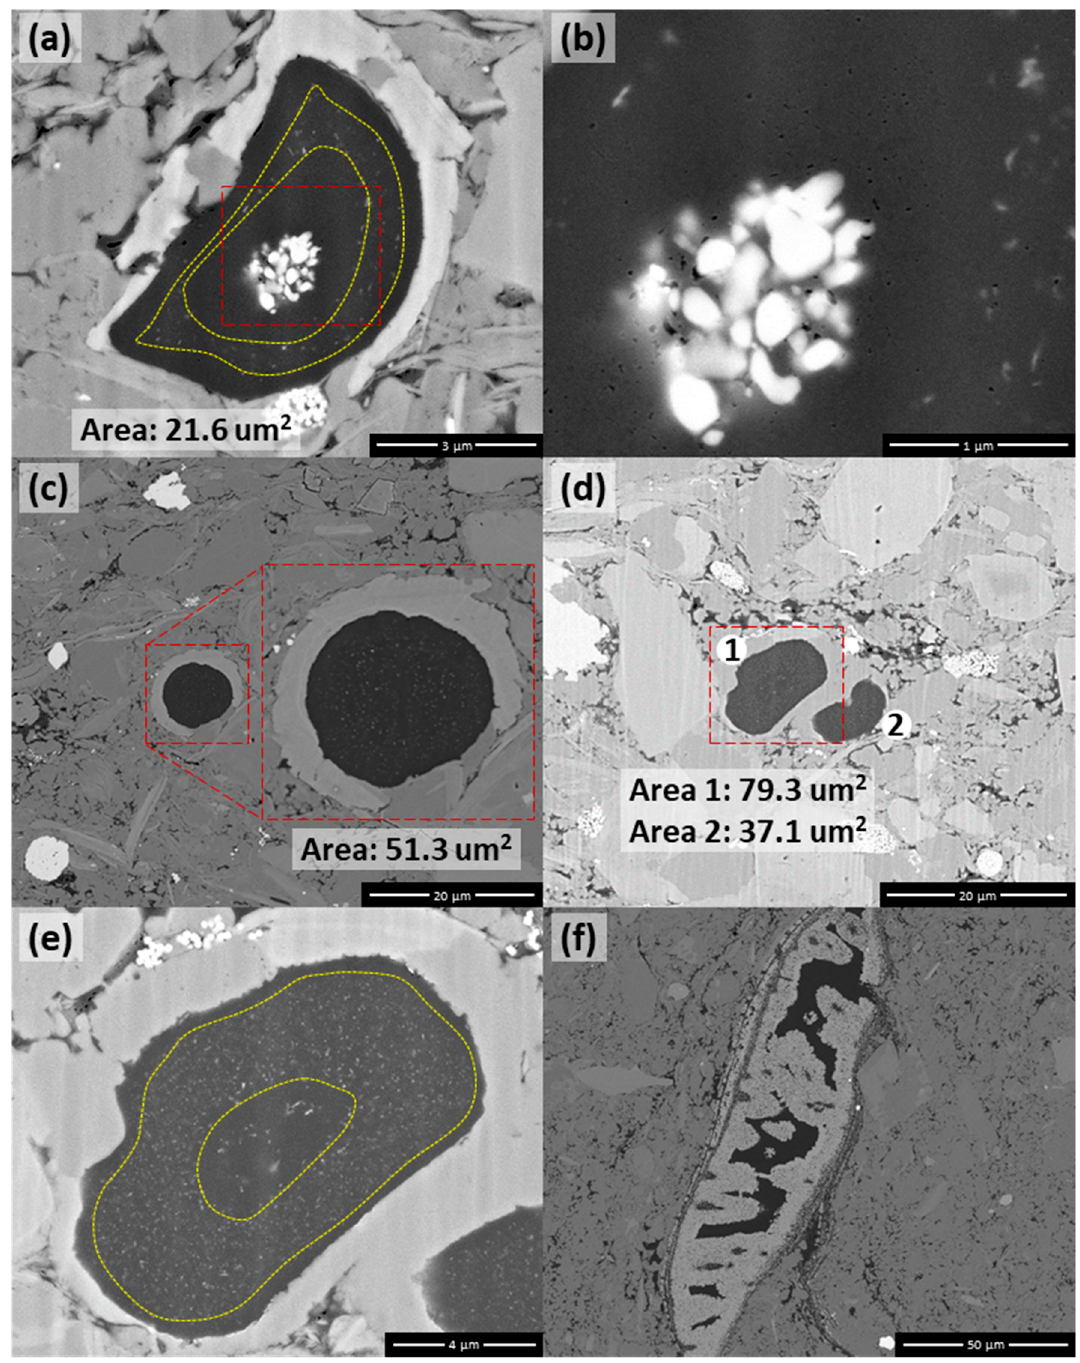
Figure 17. Examples of the nonporous kerogen bounded by biogenic minerals (OM VII) from Longmaxi-Wufeng Shale, Sichuan Basin. ( a ) SEM image JY1S-9-06 (well ID-sample no.-image no.); ( b ) SEM image JY1S-9-07, a near view of SEM image JY1S-0-06; ( c ) SEM image JY1S-9-51; ( d ) SEM image JY1S-15-10; ( e ) SEM image JY1S-15-11, a near view of SEM image JY1S-15-10; ( f ) SEM image JY1S-27-06. The red rectangle indicates the location of the near view of SEM images; the yellow dashed curve indicates the ring belt rich of tiny small apatite.